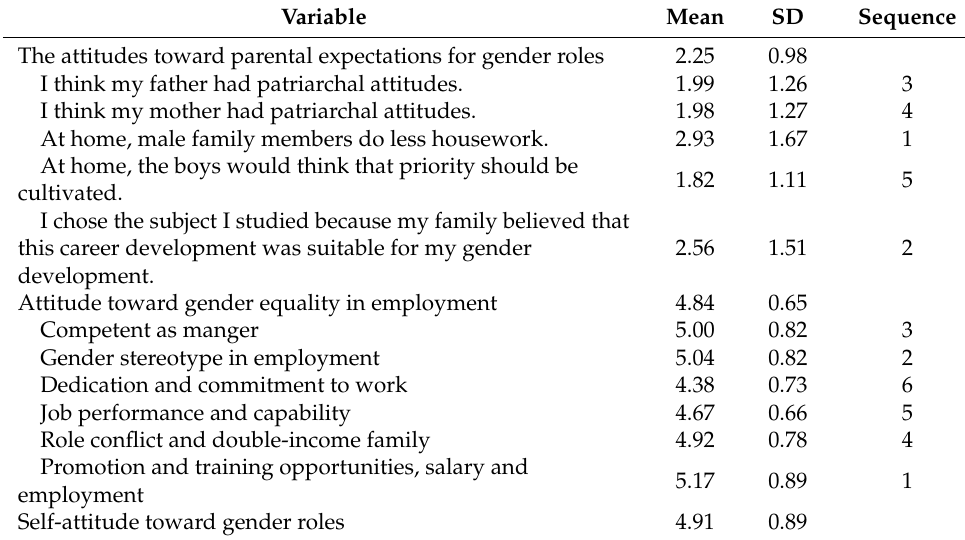
Table 2. The attitudes toward parental expectations for gender roles as well as gender quality in